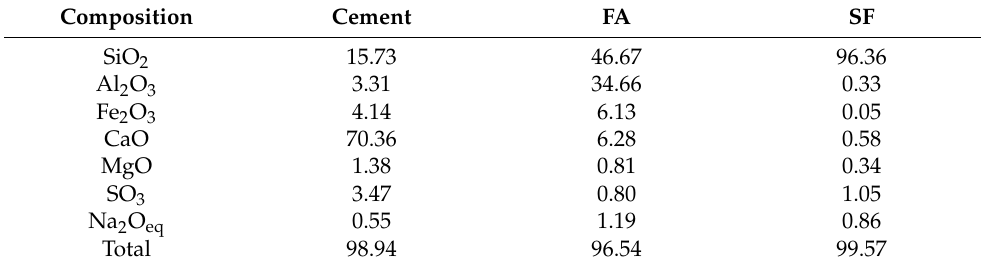
Table 1. Chemical compositions of three cementitious materials analyzed by x-ray fluorescence (XRF)/%. Composition